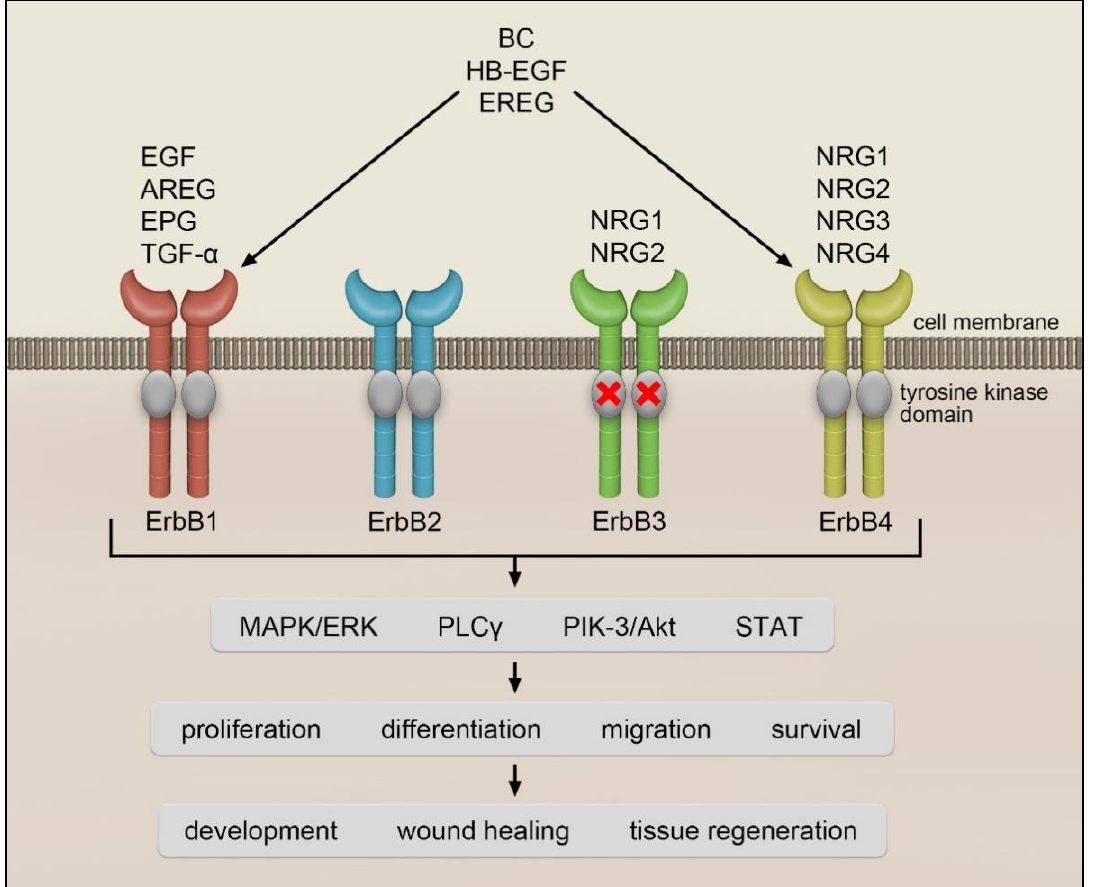
Figure 1 . ErbB receptors and their ligands . ErbB2 has no known ligand, while ErbB3 lacks intrinsic kinase activity (indicated by a cross). Following ligand binding, the receptors activate several downstream signaling pathways thereby regulating cell growth, proliferation, and survival. These processes play an important role in development, wound healing and tissue regeneration. EGF, epider- mal growth factor; TGFα , transforming growth factor- α; EPG, epigen; AREG, amphiregulin; EREG, epiregulin; BC, betacellulin; HB-EGF, heparin-binding EGF-like growth factor; NRG1-4, neuregulin 1-4; STAT, signal transducer and activator of transcription; MAPK/ERK, mitogen-activated protein kinase/extracellular signal-regulated kinase; PIK3/Akt, phosphoinositide 3-kinase/protein kinase B; PLCγ, phospholipase Cγ.